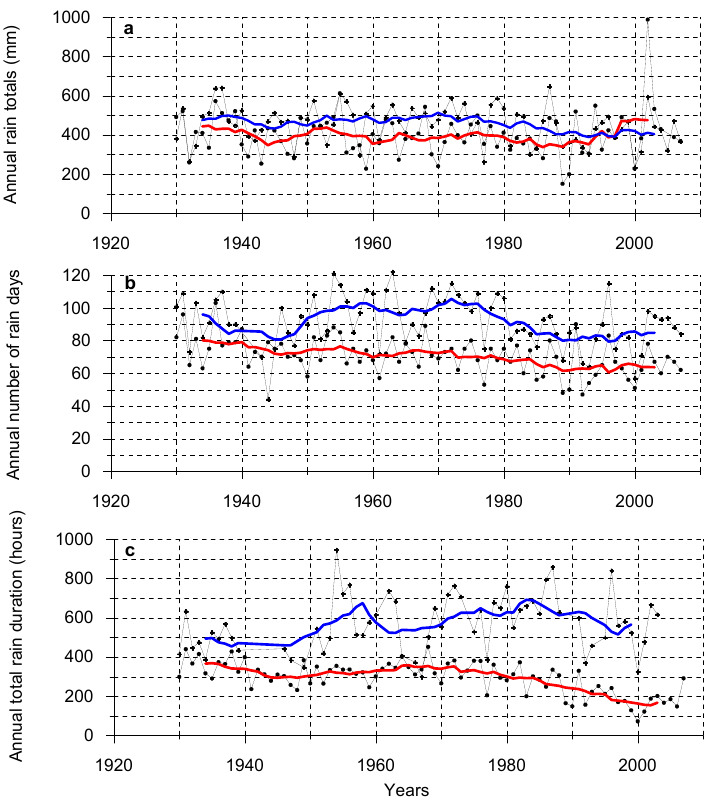
Figure 1. Time series of annual rain totals (a), annual number of rain days (b) and annual total rain duration for NOA ( ● circle) and AUTH (+cross). Red (NOA) and blue (AUTH) curves represent the Fig. 1. Time series of annual rain totals (a) , annual number of rain days (b) and annual total rain duration for NOA ( • circle) and AUTH Gaussian 9 fitting filter. (+ cross). Red (NOA) and blue (AUTH) curves represent the Gaussian 9 fitting